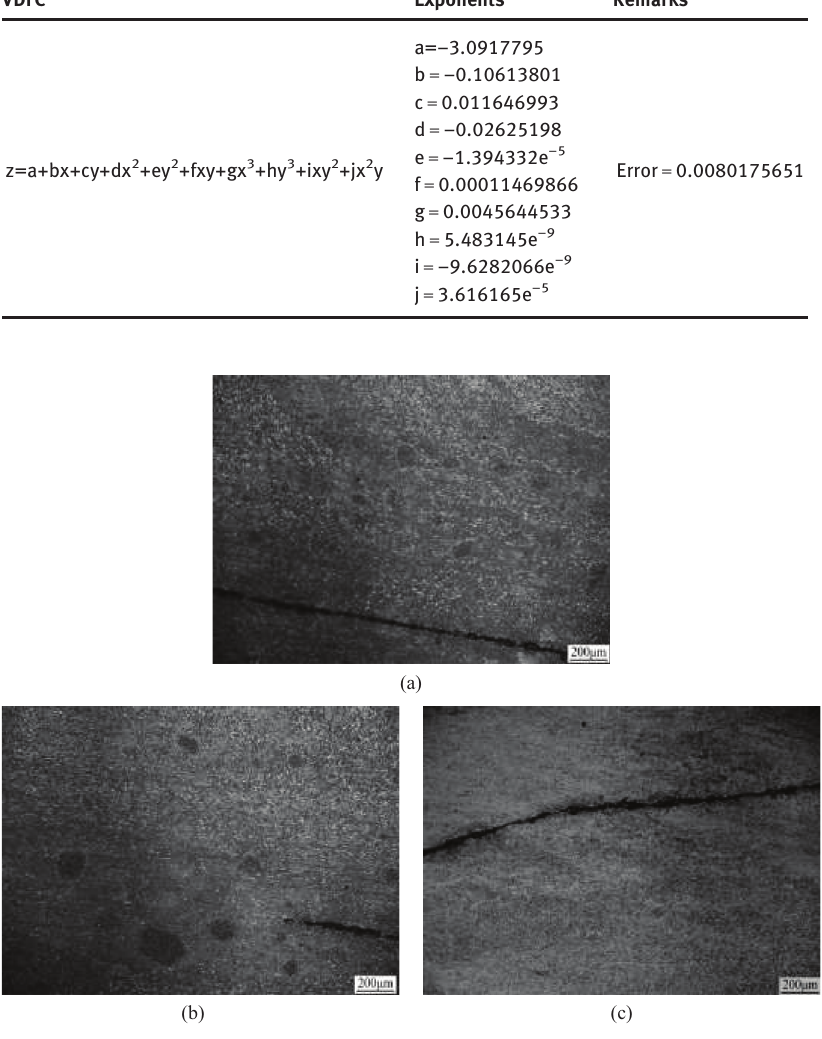
Figure 9: The microstructures of Ti-6Al-4V alloy under the deforming conditions (a) 1173 K & 1s − 1 ;drum-shaped region of deformed specimen, (b) 1173 K & 1 s − 1 ; center region of deformed specimen, (c) 1273 K & 1 s − 1 ; drum-shaped region of deformed